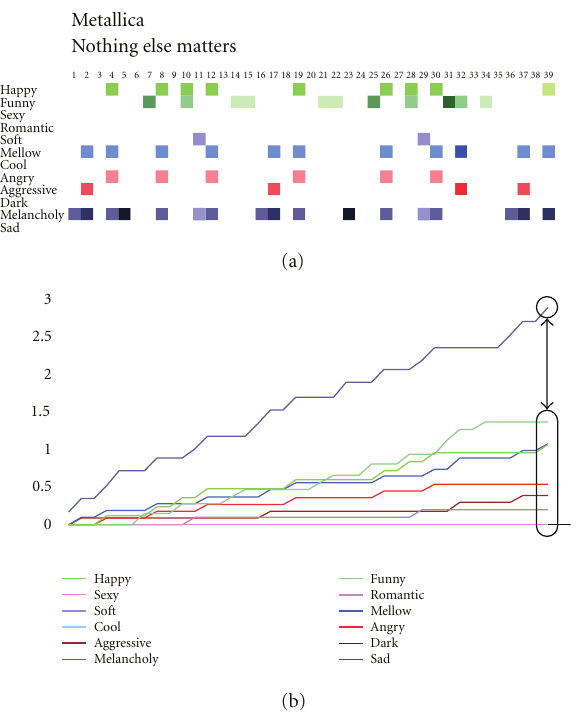
Figure 4: LSA correlation between (a) the lyrics of the song “Nothing else matters” and 12 a ff ective terms, with (b) accumulated values plotted over the entire length of the song.